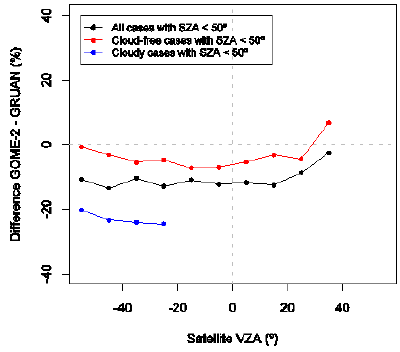
Figure 5. Differences between TWVC data retrieved by GOME-2 and GRUAN sounding data (Eq. 3) as function of satellite cloud fraction for all cases, and those with satellite SZA < 50 ◦ , and SZA > 50 ◦